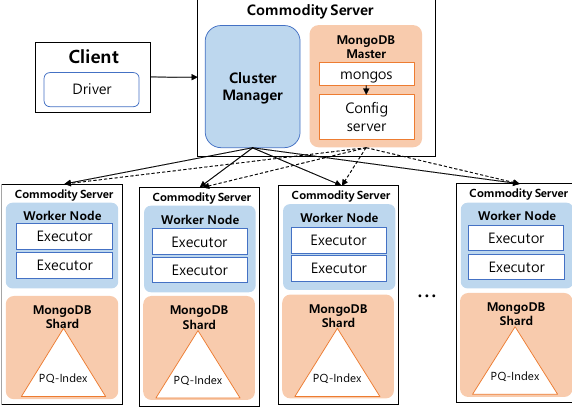
Figure 3. Distributed components of DISPAQ